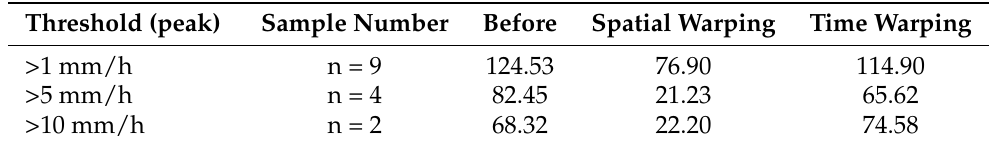
Table 5. Average position error (km) before and after warping for the “All” experiment. The average is over all time steps at which the peak (in v ) is above a certain threshold.